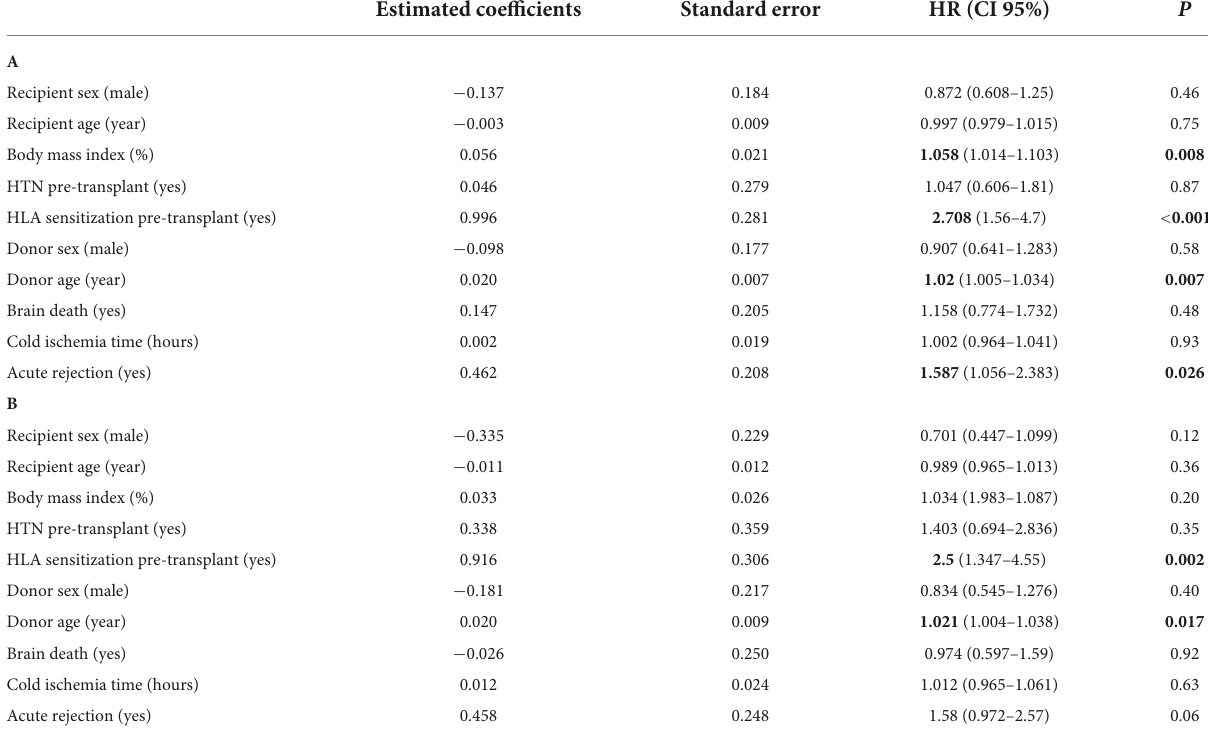
TABLE 2 Multivariate model to evaluate overall graft failure depending on recipients and donor variables in the whole study population (A) and in patients younger than 60-year series (B). Estimated coefficients Standard error HR (CI 95%)